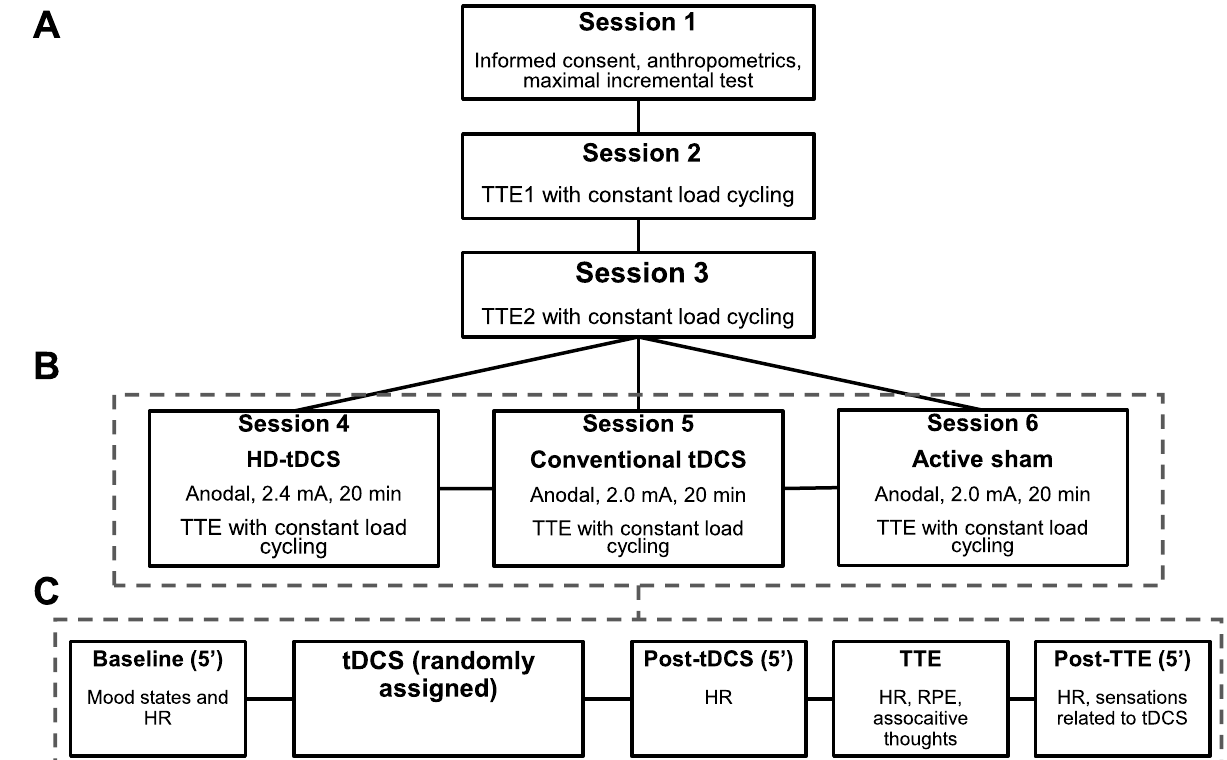
Figure 1. Flowchart of the study. Incremental test and reproducibility of the outcome measures ( A ), experimental phase ( B ), detailed experimental phase sessions ( C ). Note: the order of the experimental sessions was randomized, the numbers in the boxes do not imply a fixed order. HD-tDCS = high-definition transcranial direct current stimulation; HR = heart rate; RPE = ratings of perceived exertion; tDCS = transcranial direct current stimulation; TTE = time to